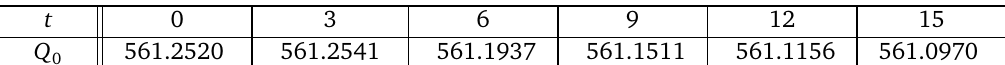
Table 2: Numerical values of the total particle density Q parameters are: σ “ 10, log p 2 T have computed (4) in the main paper and performed a cubic spline interpolation, implementing additional grid points whose spacing in x is ∆ x “ 10 ´ 5 . Q ically conserved, up to a variation on the first decimal place, which can be attributed to the discretisation